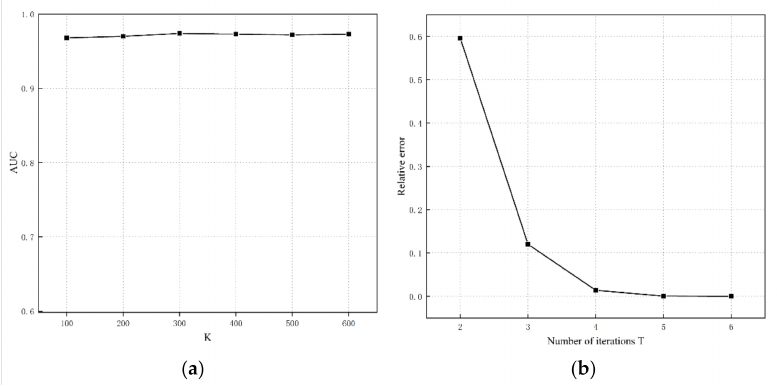
Figure 10. The effect of ( a ) k and ( b ) T on the presented method.